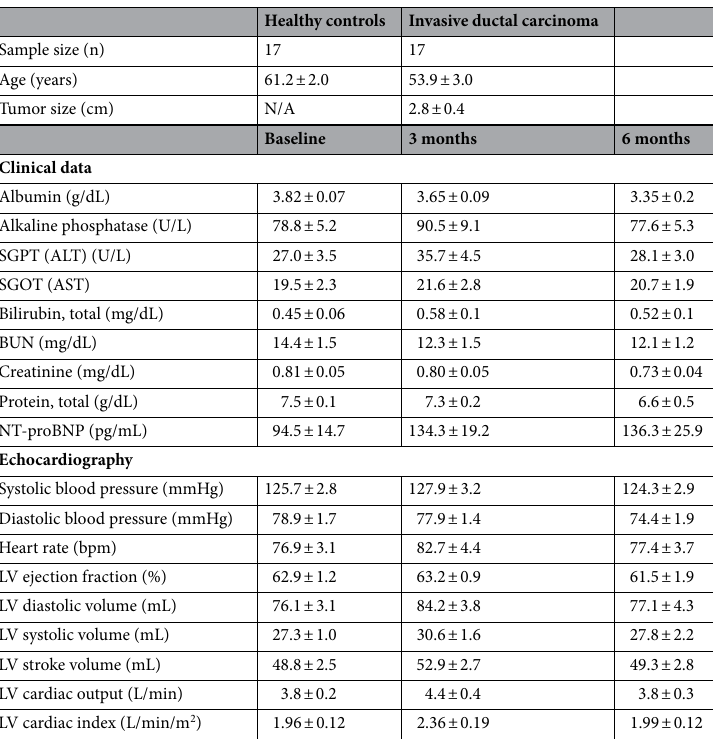
Table 1. Summary of patient demographics, clinical profile and echocardiography parameters. The table summarizes basic characteristics of the study population with further assessment of key parameters from clinical profile and echocardiography in patients with invasive ductal carcinoma at each study interval of anthracycline treatment. There was no significant difference in the clinical and echocardiography parameters at any study interval, suggesting the prognostic efficacy of early progressive alterations in biomarker. Values represent means ±